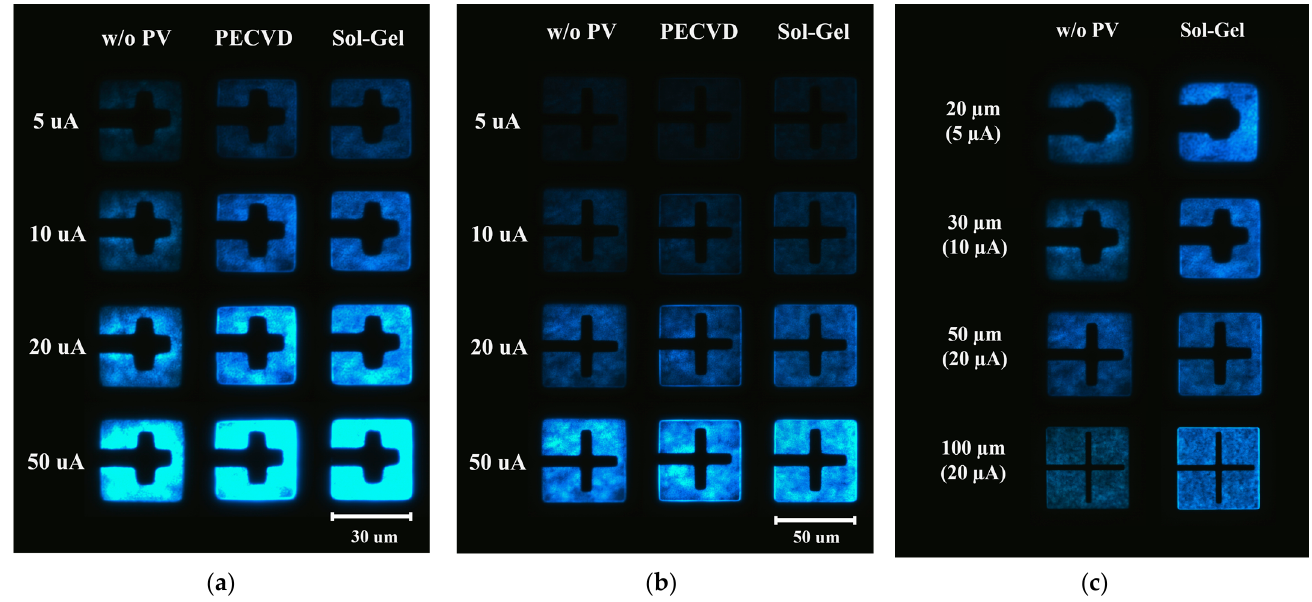
Figure A2. EL emission images of S1, S2, and S3 for ( a ) 30 × 30 µ m, ( b ) 50 × 50 µ m, and ( c ) low-current density emission.